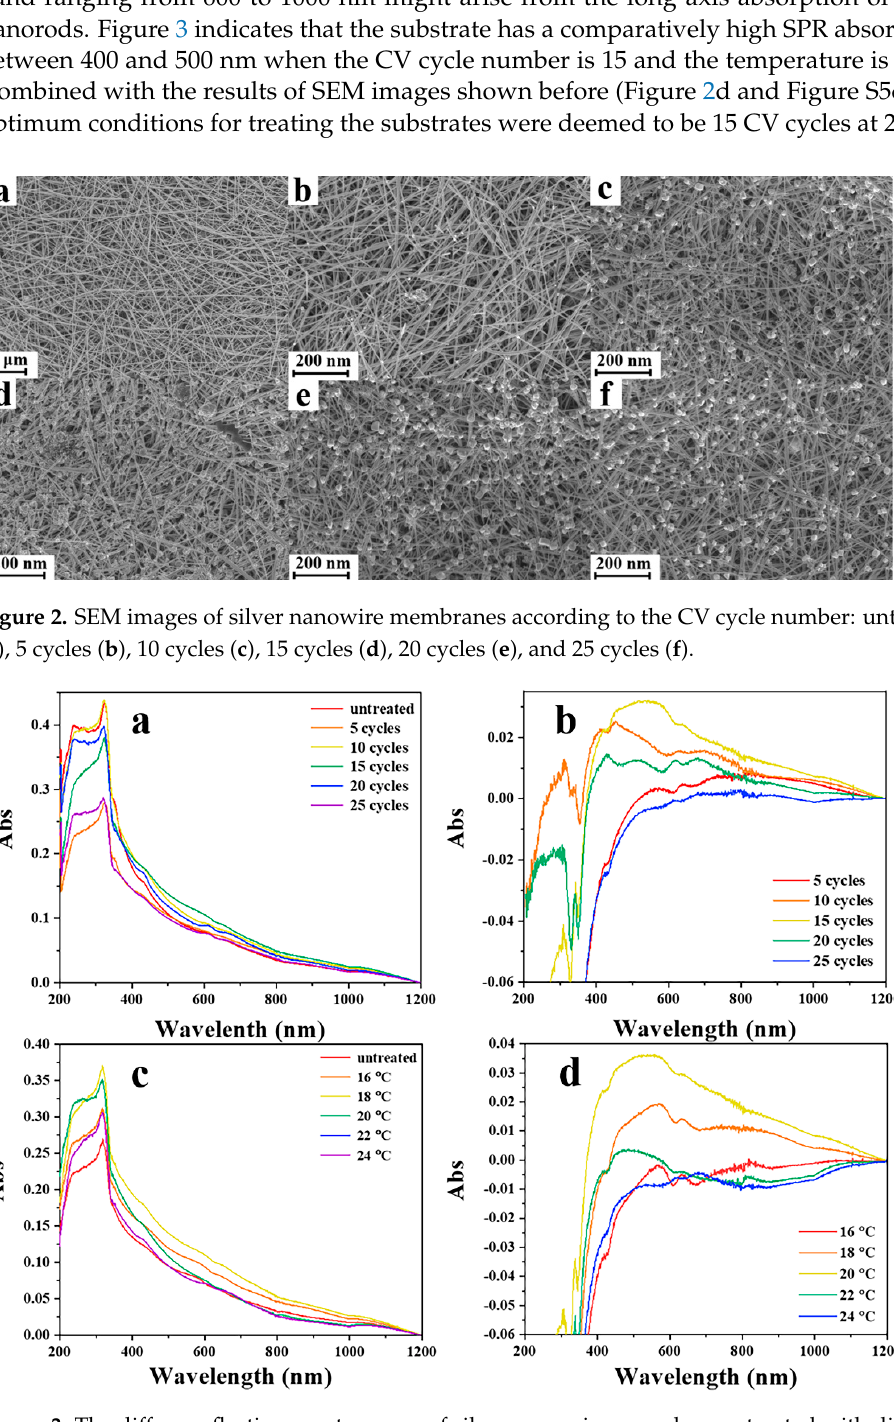
Figure 3. The diffuse reflection spectroscopy of silver nanowires membranes treated with different cycle numbers ( a ) and at different temperatures ( c ). Absorption spectrum by subtracting the absorption spectrum of the untreated substrate from that treated with different cycles (5, 10, 15, 20, and 25) by using cyclic voltammetry ( b ). Absorption spectrum by subtracting the absorption spectrum of the untreated substrate from that treated at different temperatures (16, 18, 20, 24, and 26 °C) by using cyclic voltammetry ( d ).